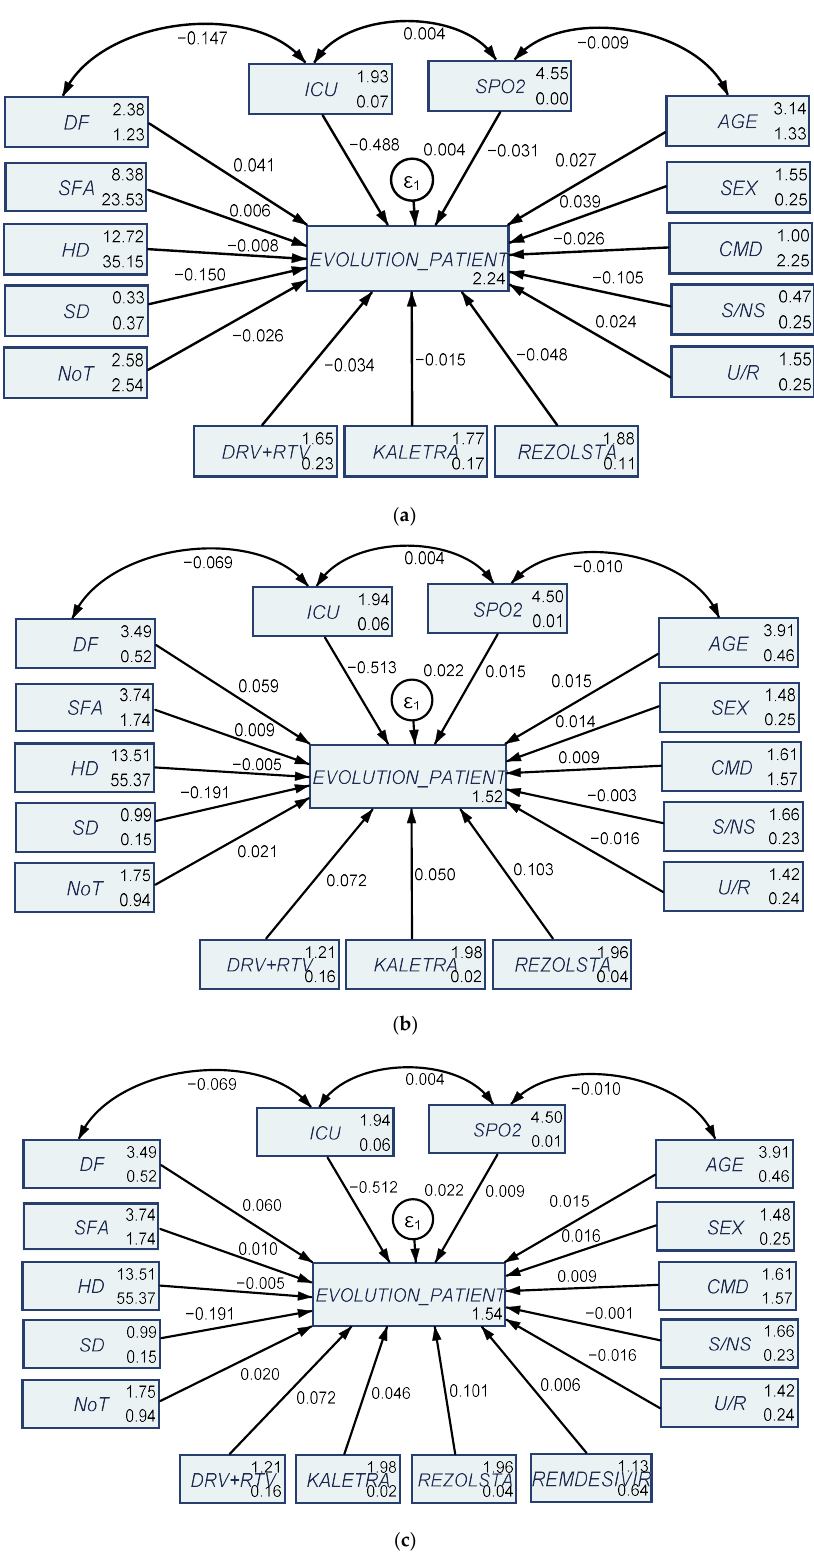
Figure 4. SEM results obtained through the maximum likelihood estimation method: ( a ) first sample of 145 COVID-19 patients from the first wave of infection; ( b ) second sample of 129 COVID-19 patients from the second wave—first treatment scheme; ( c ) second sample of 129 COVID-19 patients from the second wave—second treatment scheme with Remdesivir. Source: Own configuration in RStudio version 3.6.3. By analyzing SEM results we note that in the first wave of infection the treatment schemes tend to have an inverse impact on the evolution of the patient (negative estimated coefficients of −0.034 for DRV-RTV, −0.015 for kaletra, and −0.048 for rezolsta, significant at 1% and 5% thresholds, Figure 4a and Table A2). In the second wave of infection, SEM results entail a positive impact the treatment methods applied (Figure 4b and Table A2, positive estimated coefficients of 0.072 for DRV + RTV, 0.050 for kaletra and 0.103 for re- zolsta, respectively Figure 4c and Table A2, positive estimated coefficients of 0.072 for DRV + RTV, 0.046 for kaletra, 0.101 for rezolsta and 0.006 for remdesivir—introduced to